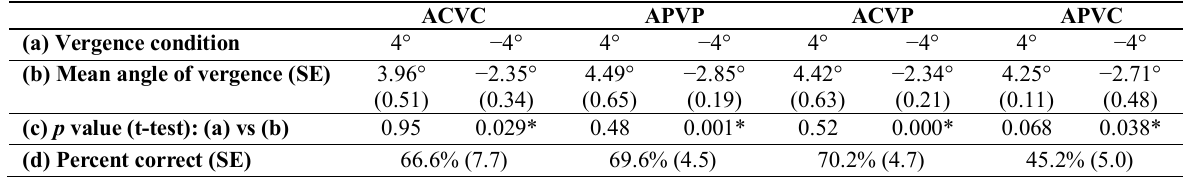
Note. ACVC condition (attention and vergence directed to the center); APVP condition (attention and vergence directed to the periph- ery); ACVP condition (attention directed to the center, and vergence to the periphery); APVC condition (attention directed to the periphery and vergence to the